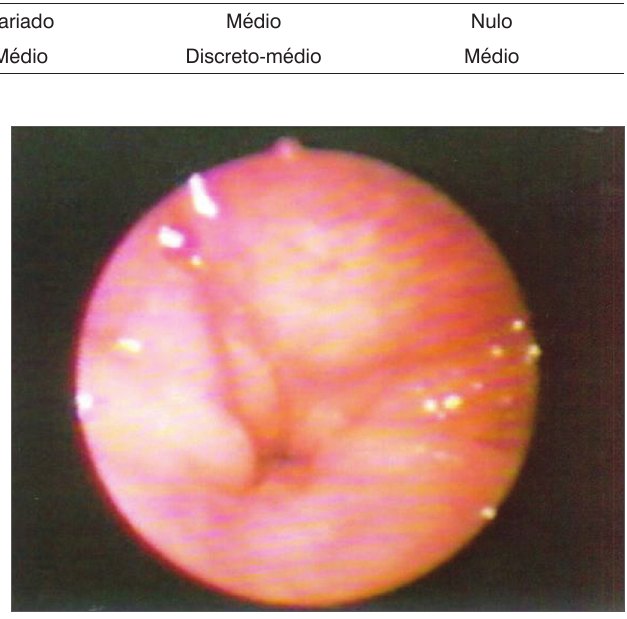
Figura 8. Paciente 4: fechamento do EVF em registro basal